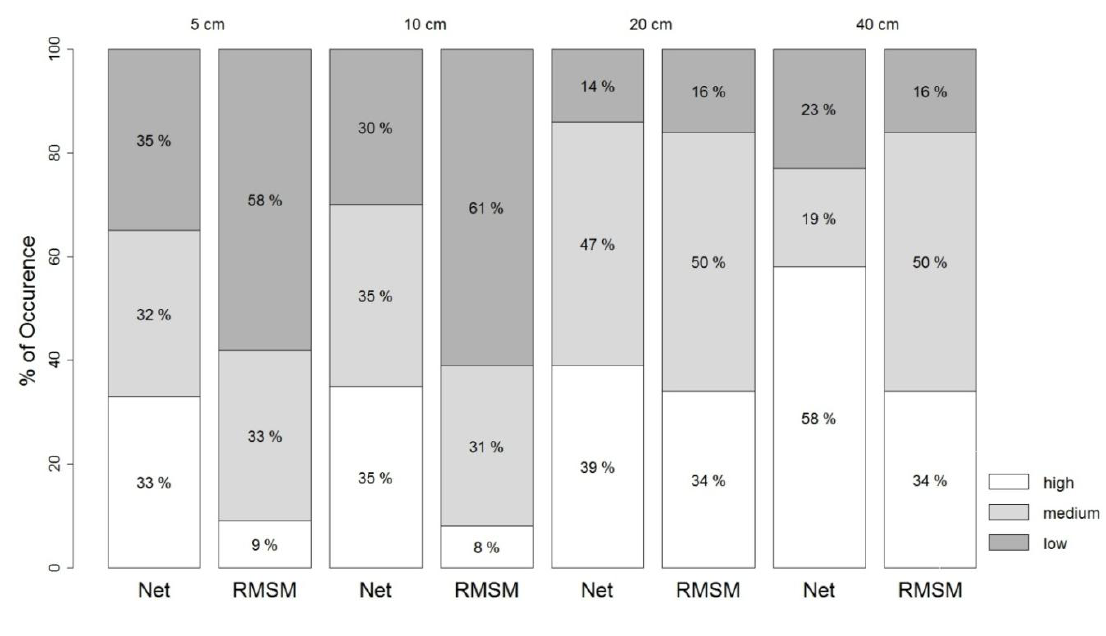
Figure 7. Bar plot showing occurrence (%) for high, medium and low correlation at 5 cm, 10 cm, 20 cm and 40 cm depths. For high correlation , for low correlation .